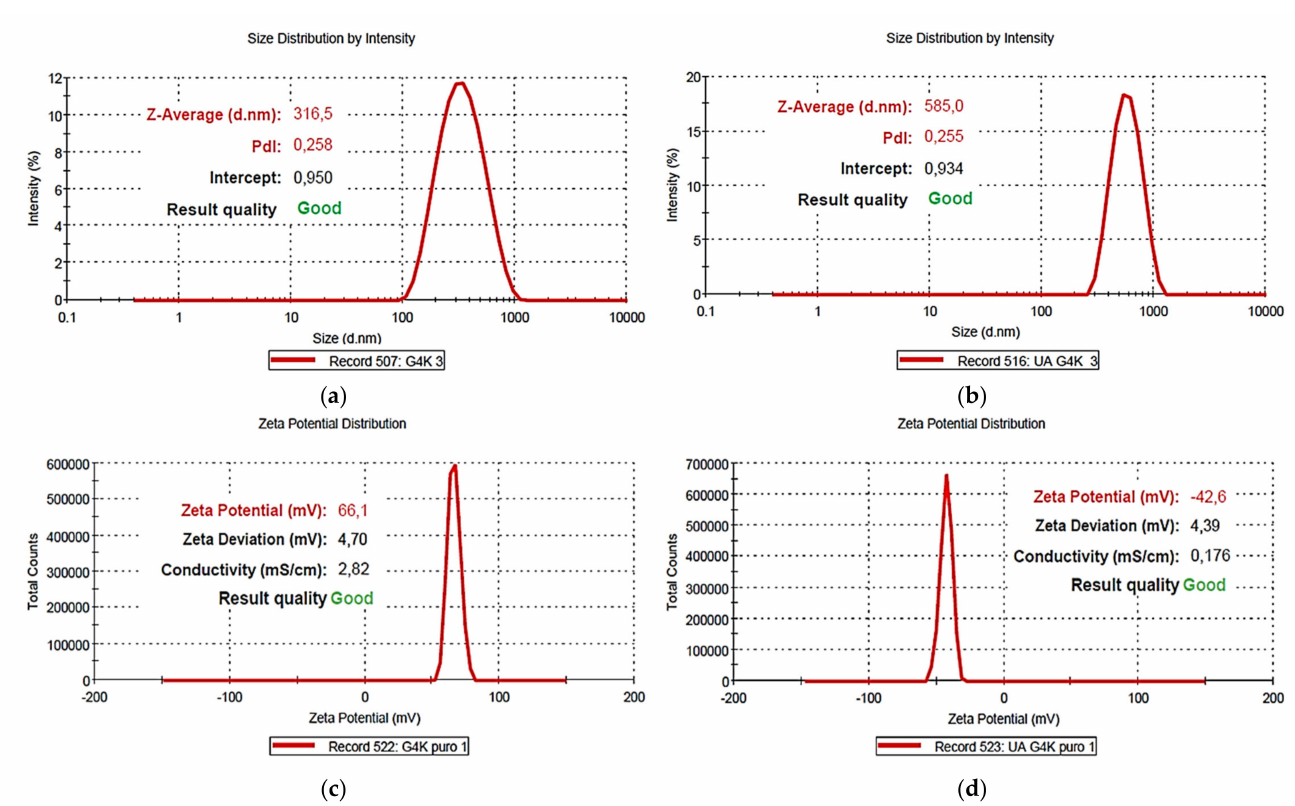
Figure 13. Representative particle size distribution of G4K ( a ) and of UA-G4K ( b ) and representative ζ -p distributions of G4K ( c ) and UA-G4K ( d